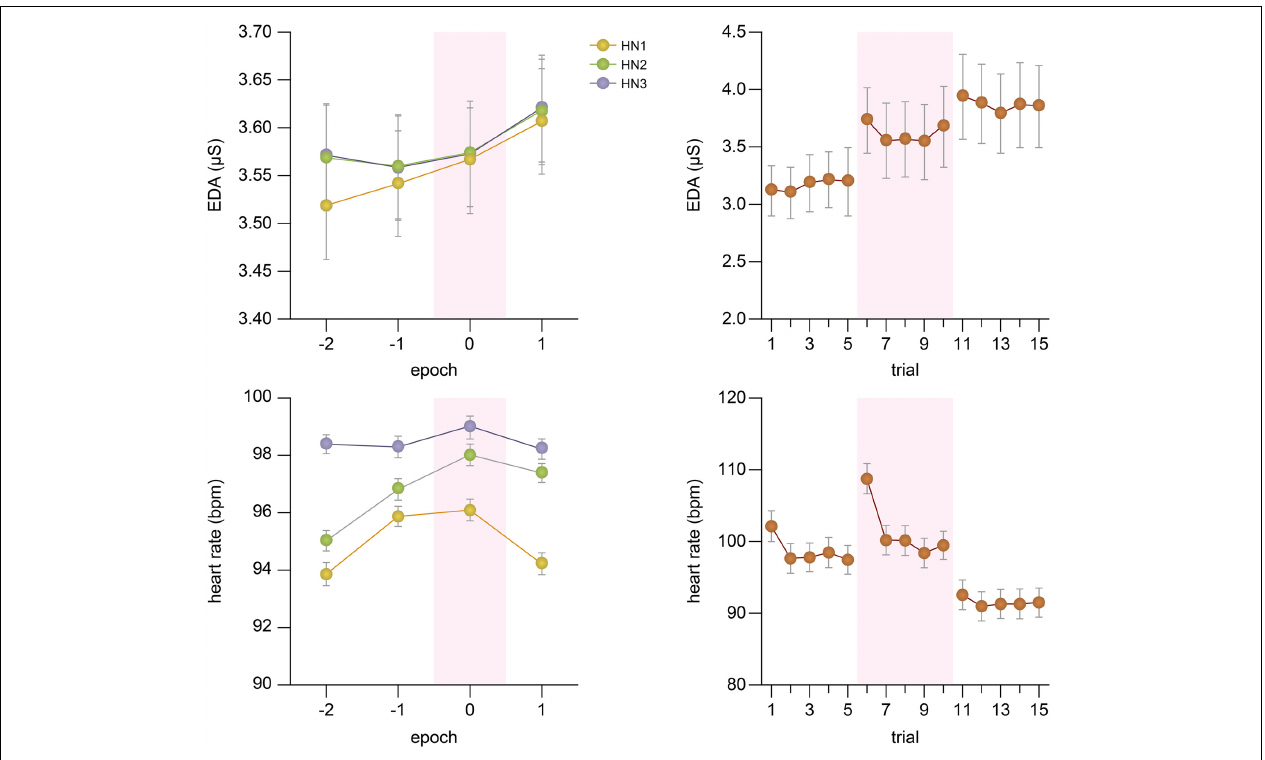
FIGURE 3 | EDA and heart rate changes within and across trials. In the left panels, the physiological responses around the time of the high notes are depicted over four epochs of 2 seconds each. Epoch 0 is aligned with the respective metronome beat for High